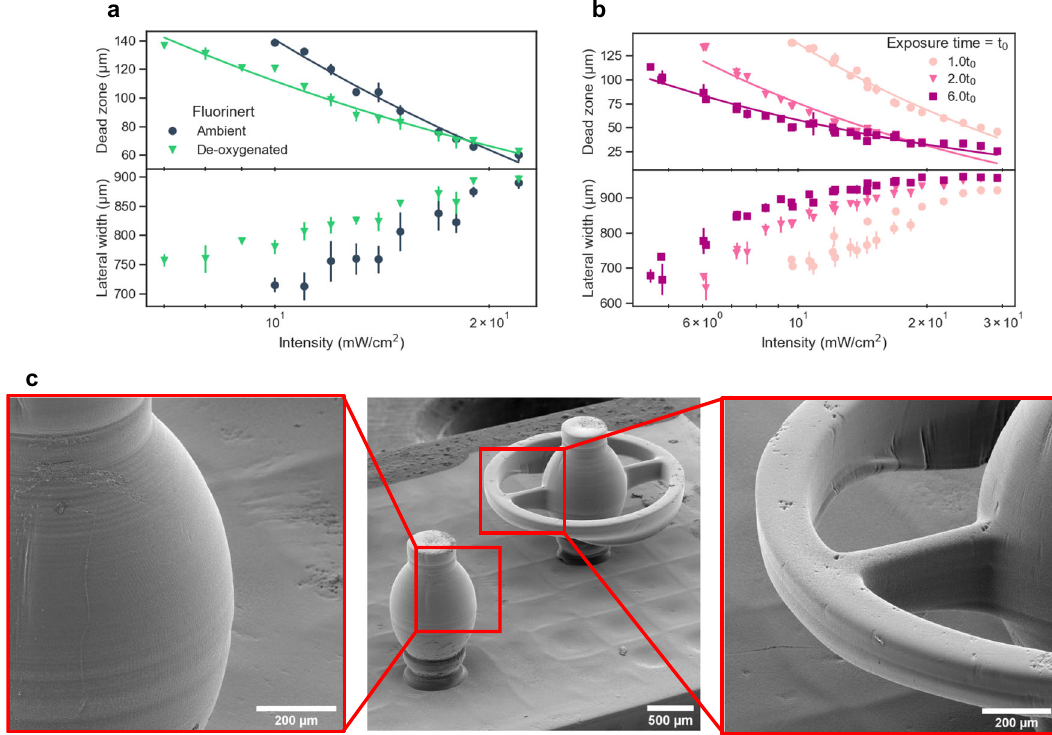
Fig. 2 Oxygen from the inert liquid enables continuous growth. a Comparison of Fluorinert (inert liquid) with and without de-oxygenation and its effect on the dead zone thickness and lateral cured width as a function of exposure intensity. b Effect of exposure intensity and time on the dead zone thickness and lateral cured width for a differential resin thickness of 150 μ m. Decreasing exposure time is commensurate with a faster growth rate in the continuous growth mode. The targeted lateral dimension in both a and b was 1000 μ m. The vertical error bars in a and b represent the standard deviation of repeatability. c Smooth-surfaced ellipsoidal microstructures fabricated at a rate of 3 μ m s − 1 in the continuous growth mode using a static liquid interface.